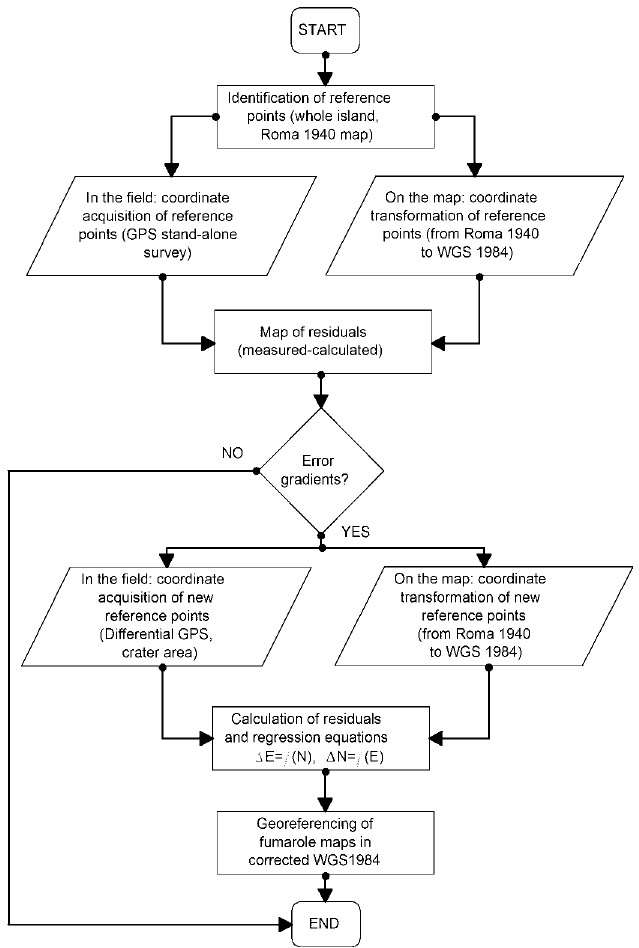
Figure 7. Logical flow-chart summarizing the whole coordinate conversion process.